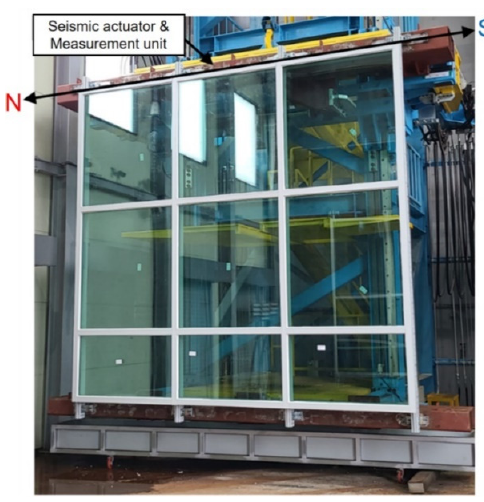
Figure 9. Dynamic seismic test method based on AAMA 501.6.